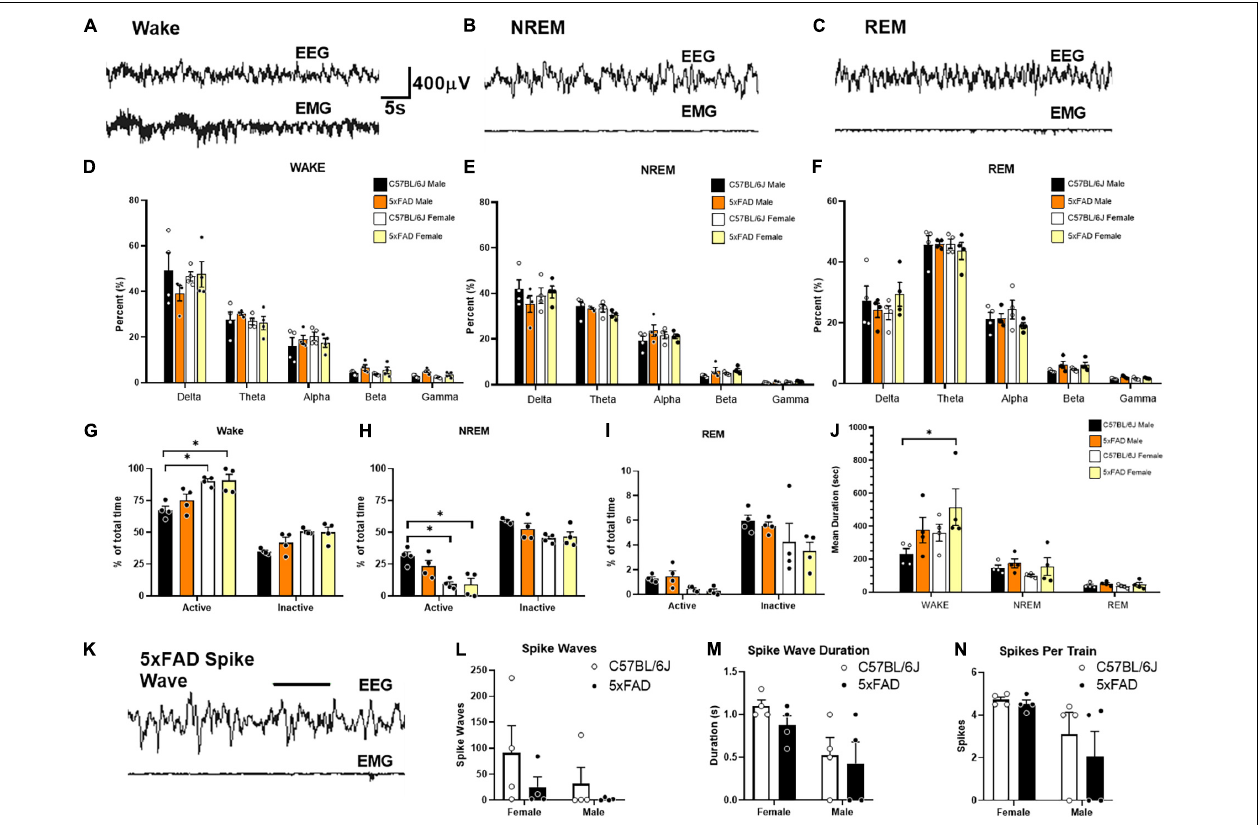
FIGURE 3 | No emergent phenotypes of sleep or spike-wave activity in 5XFAD mice. No emergent phenotypes of sleep or spike wave activity in 5XFAD mice. Sleep and seizure activity was assessed by EEG in female and male 5XFAD mice ( n = 4 per group). Example traces during epochs of wake (A) , NREM sleep (B) , and REM sleep (C) are displayed across the top. No statistical differences in frequency are measured during wake (D) , NREM (E) , or REM (F) . Analysis of sleep phase distribution during each activity period throughout the 72 h recording does not reveal significant differences in time spent in each respective sleep phase. Increased wake (G) , and decreased NREM sleep (H) is witnessed in female mice during both activity phases compares to male controls. Differences in REM sleep (I) are not seen. Mean duration of wake epochs are significantly increased in females compared to male controls (J) . An example of a putative spike wave identified using pike sorting criteria (K) . No significant differences in spike wave activity (L) , spike wave duration (M) , or spikes per train (N) , are identified for sex or